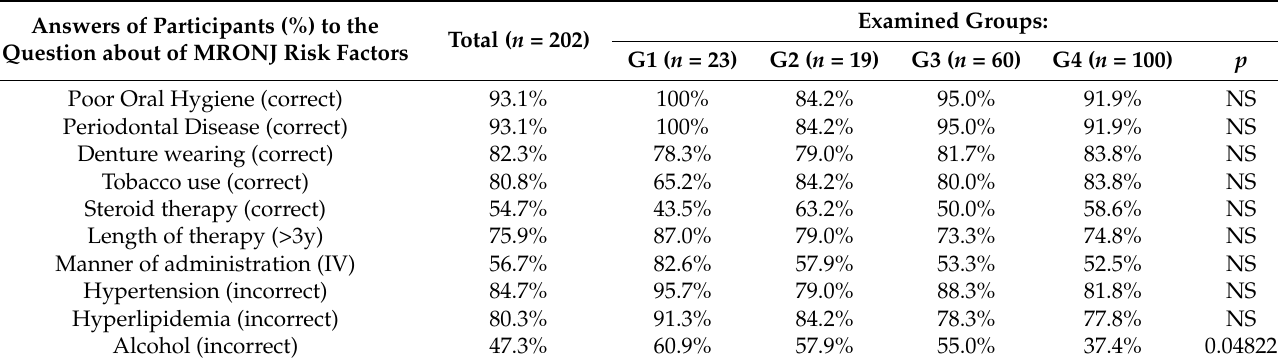
Table 4. Risk factors of MRONJ.